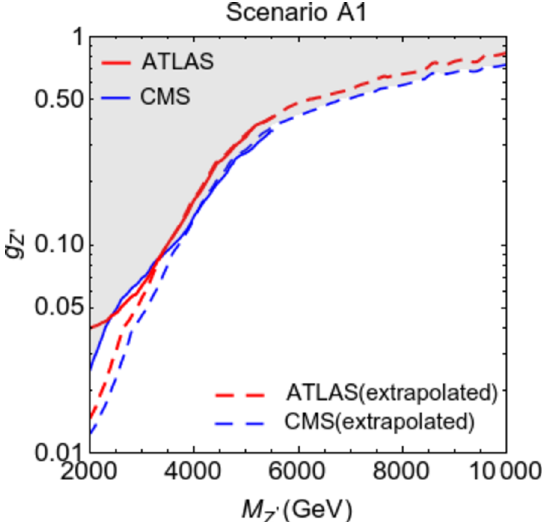
Figure 6 . Our calculated dimuon limits for scenario A1 in the ( M Z 0 , g Z 0 ) plane, using the procedure described in the text. The comparison with the published results of ATLAS [32] and CMS [33] collaboration shows that our extrapolated results (dashed) agree with the published limits (solid) for high values of M . The matching for M & 3 . 5 TeV for other scenarios in table 3 is at a similar Z 0 Z 0 level. The gray shaded band in the figure highlights the full constraint used, i.e. published limits from [33] upto M 5 . 5 TeV and the extrapolated limits in the range 5.5 TeV < M 10 Z 0 < Z 0 <